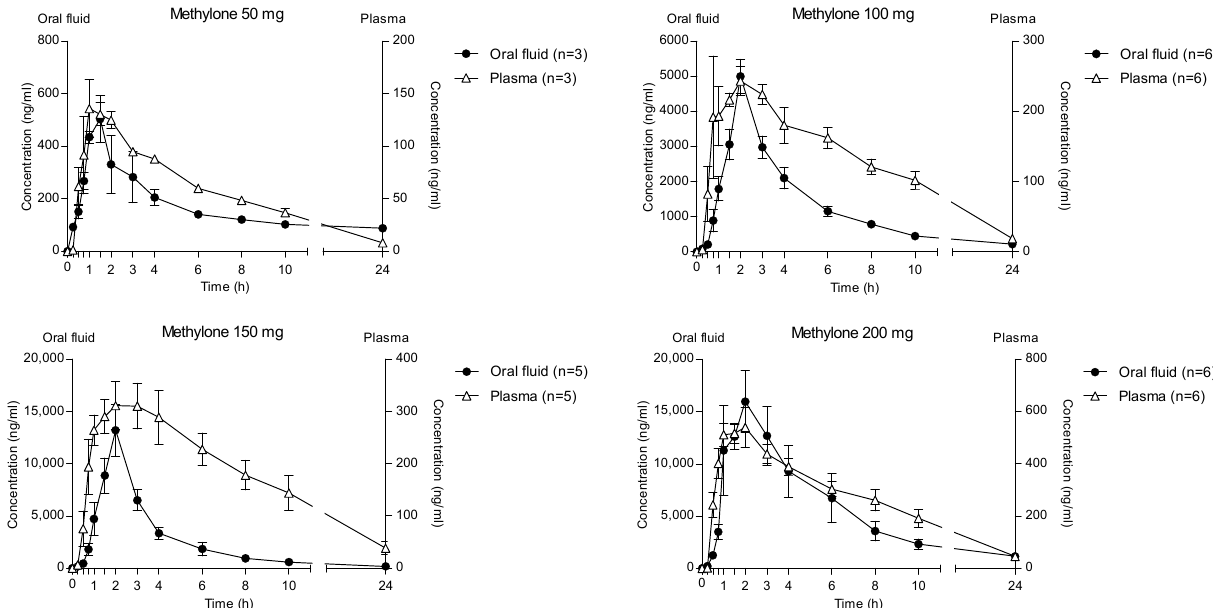
The time course of di ff erent methylone doses in OF and plasma is reported in Figure 6. Methylone reached the highest concentration in both matrices at 2 h after administration of di ff erent doses, but the OF values were signi fi cantly higher than those in plasma. Spe- ci fi cally, the main ratios between the OF and plasma C max were 3.6, 16.4, 37.7 and 33.9 after the administration of 50, 100, 150 and 200 mg methylone, respectively.